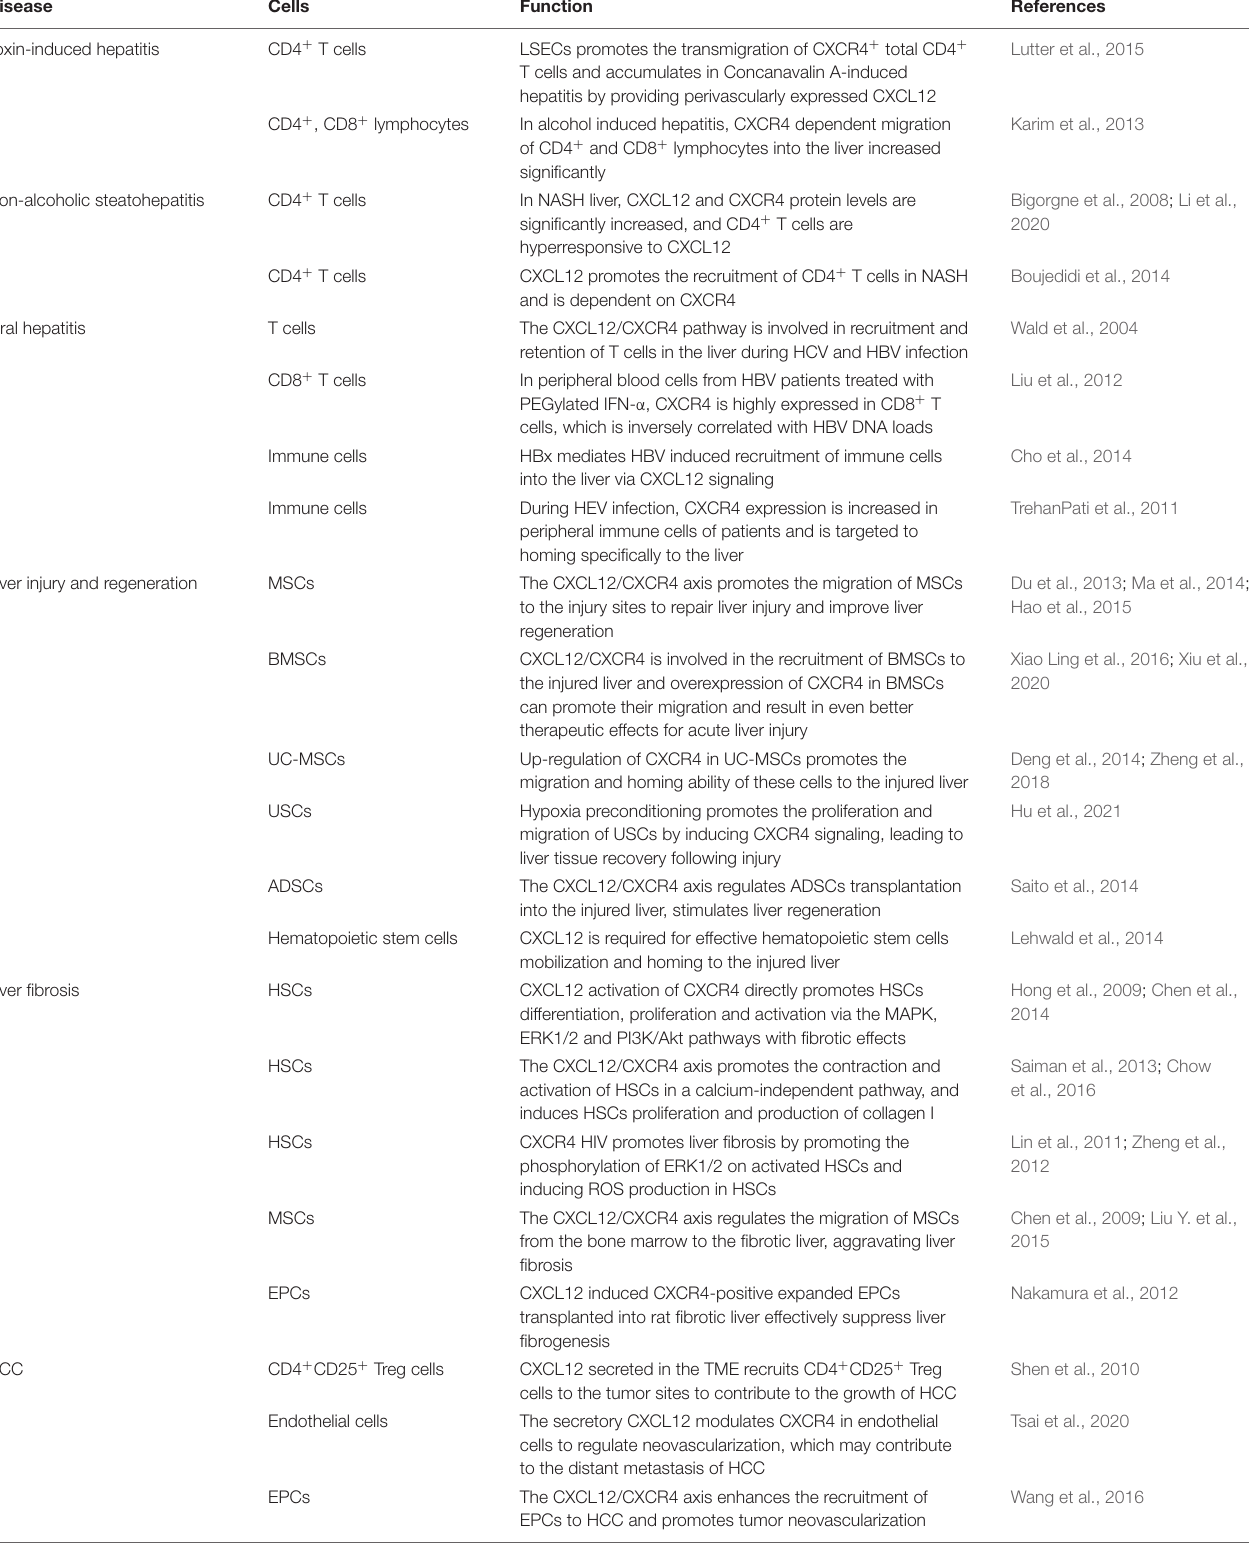
TABLE 1 | Involvement of CXCR4 and its ligand in liver disease.